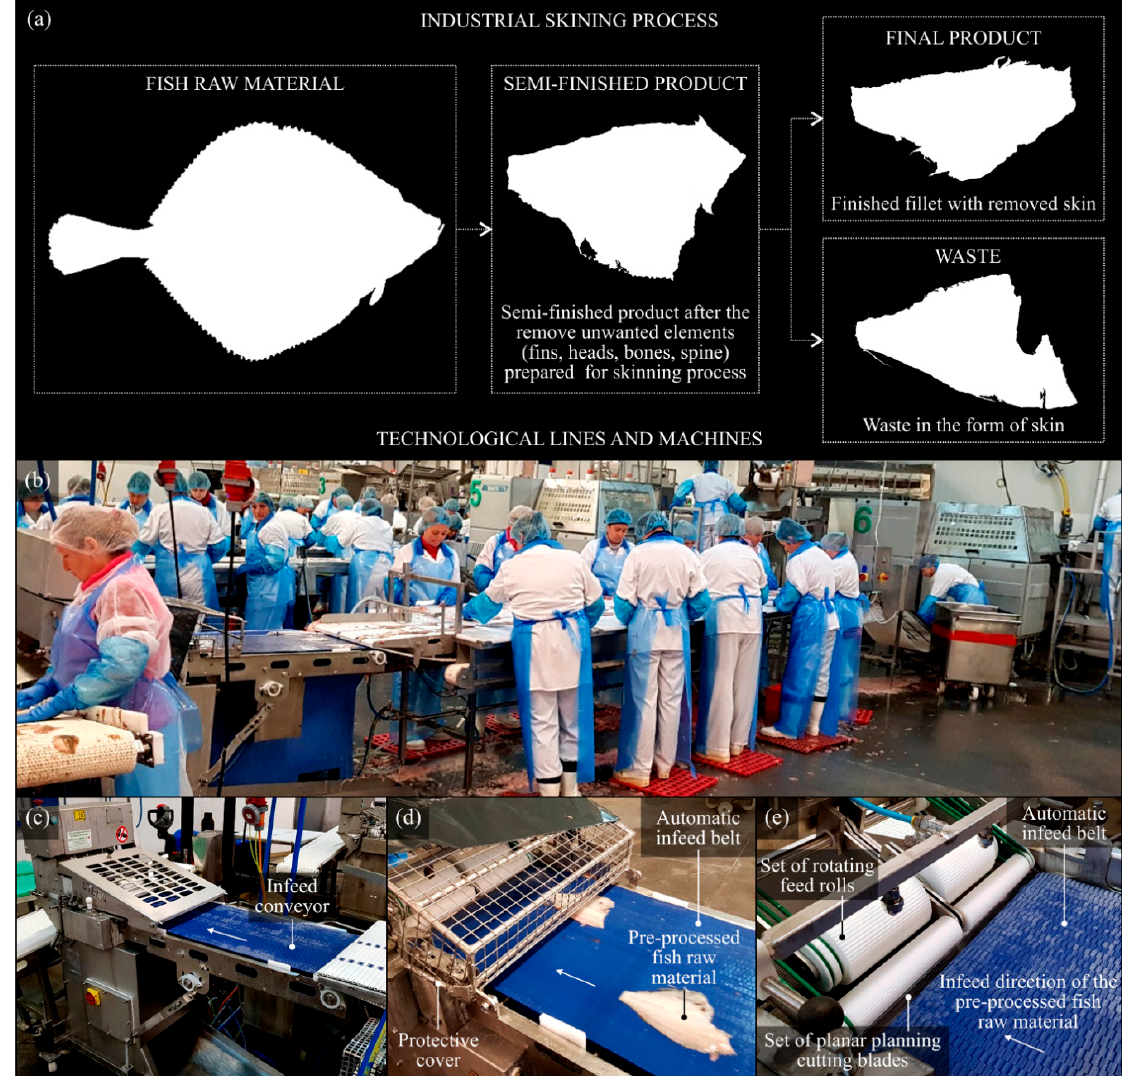
Figure 1. The production process carried out on the technological line for the processing (skinning) of flat fishes from Pleuronectidae family, based on the example of the a medium-sized fish processing plant (Espersen Koszalin Sp. z o.o., Koszalin, Poland): ( a ) general diagram of the industrial skinning process; ( b ) general view of one of the technological lines; ( c )automatic skinning machine ST600 (Steen F.P.M. International, Kalmthout, Belgium); ( d ) close-up of the infeed conveyor a pre-processed raw fish material; ( e ) close-up of the set of planar cutting blades mounted under the rotating feed rolls.